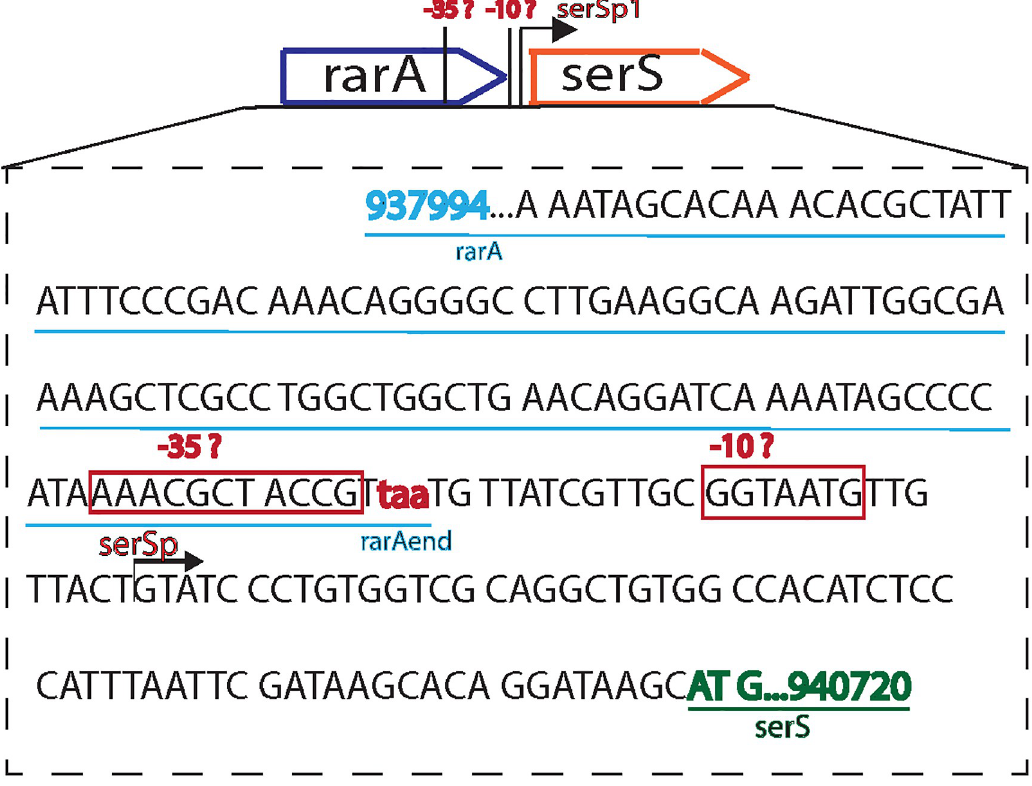
Fig 1. Identification of possible promoter/regulatory sequence of serS within the rarA sequence. Representation of predicted promoter sequences and their location in the last 40 amino acids region of rarA .